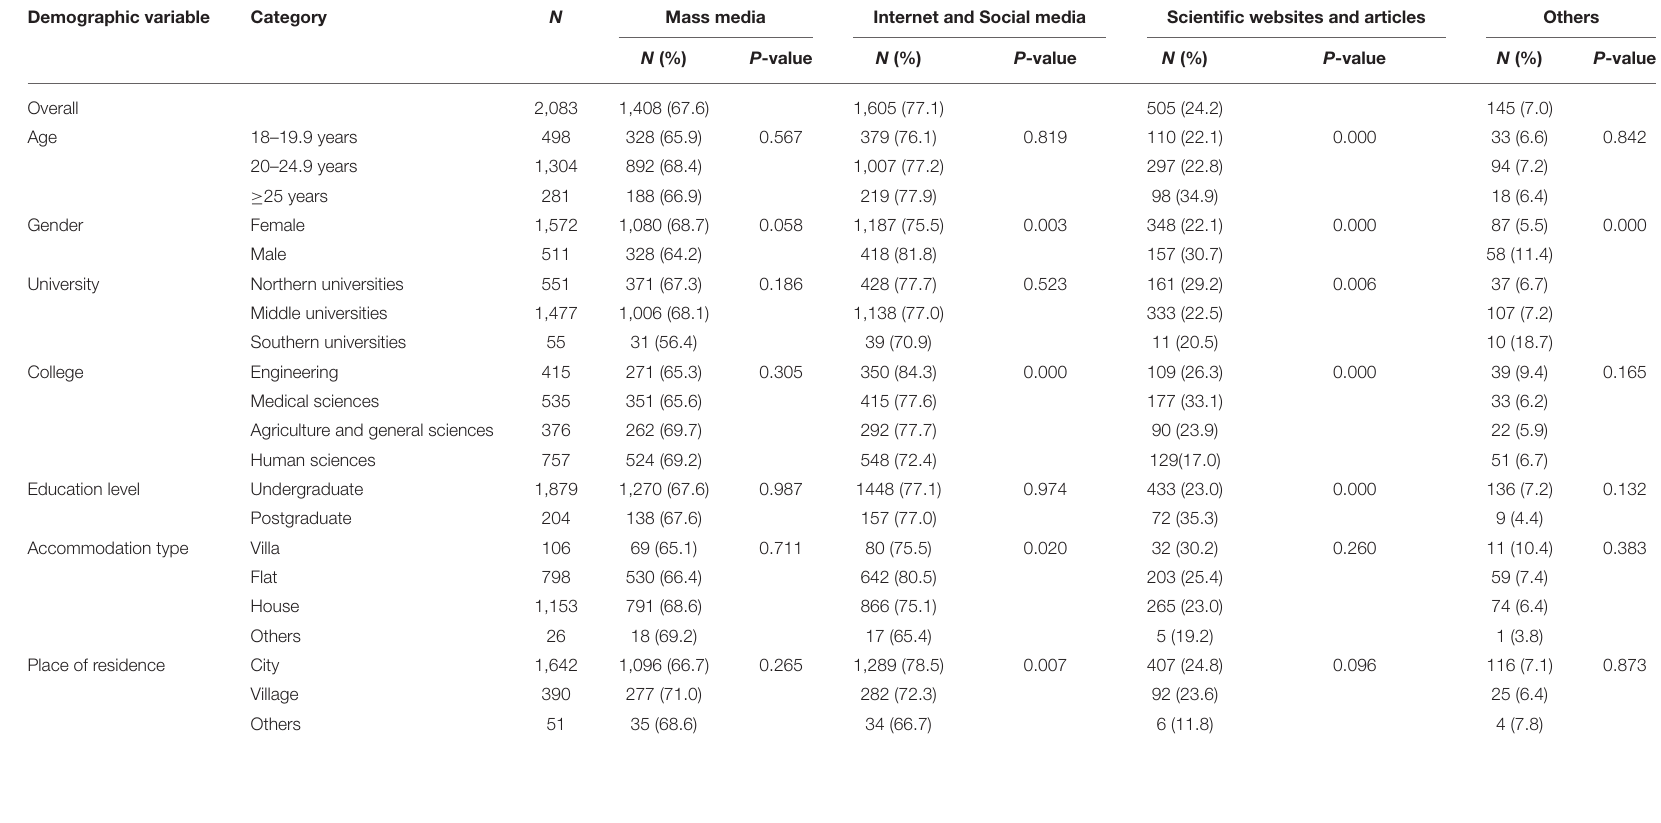
TABLE 4 | Source of information about COVID-19 among university students in Jordan by socio-demographic variables. Demographic